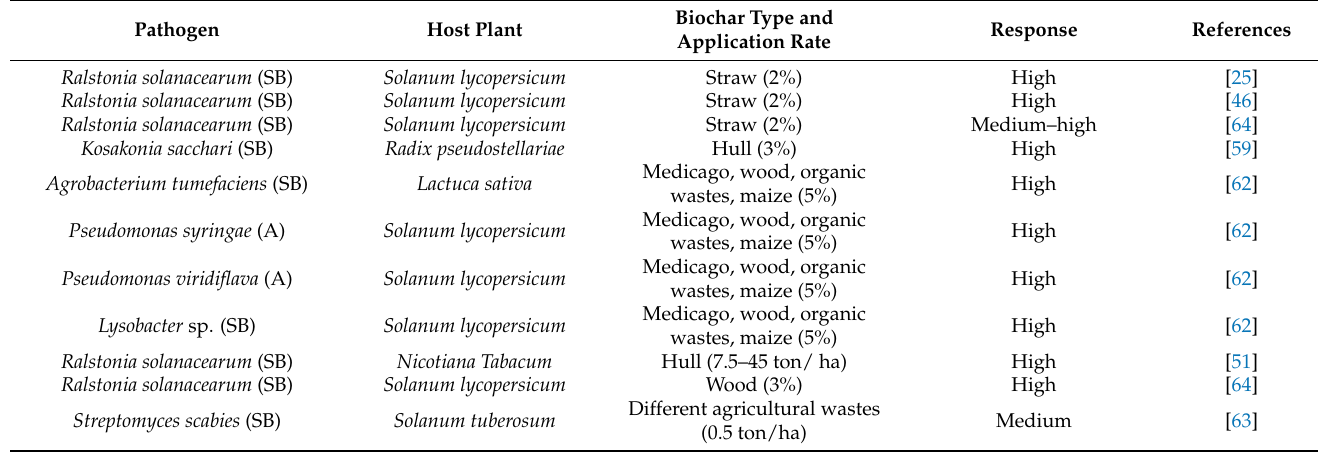
Table 3. List of experimental studies examples that applied biochar as a soil amendment to control plant diseases caused by airborne (A) and soilborne (SB) bacterial plant pathogens. Pathogen, host plant, biochar feedstock type, response level, and reference are reported for each study.